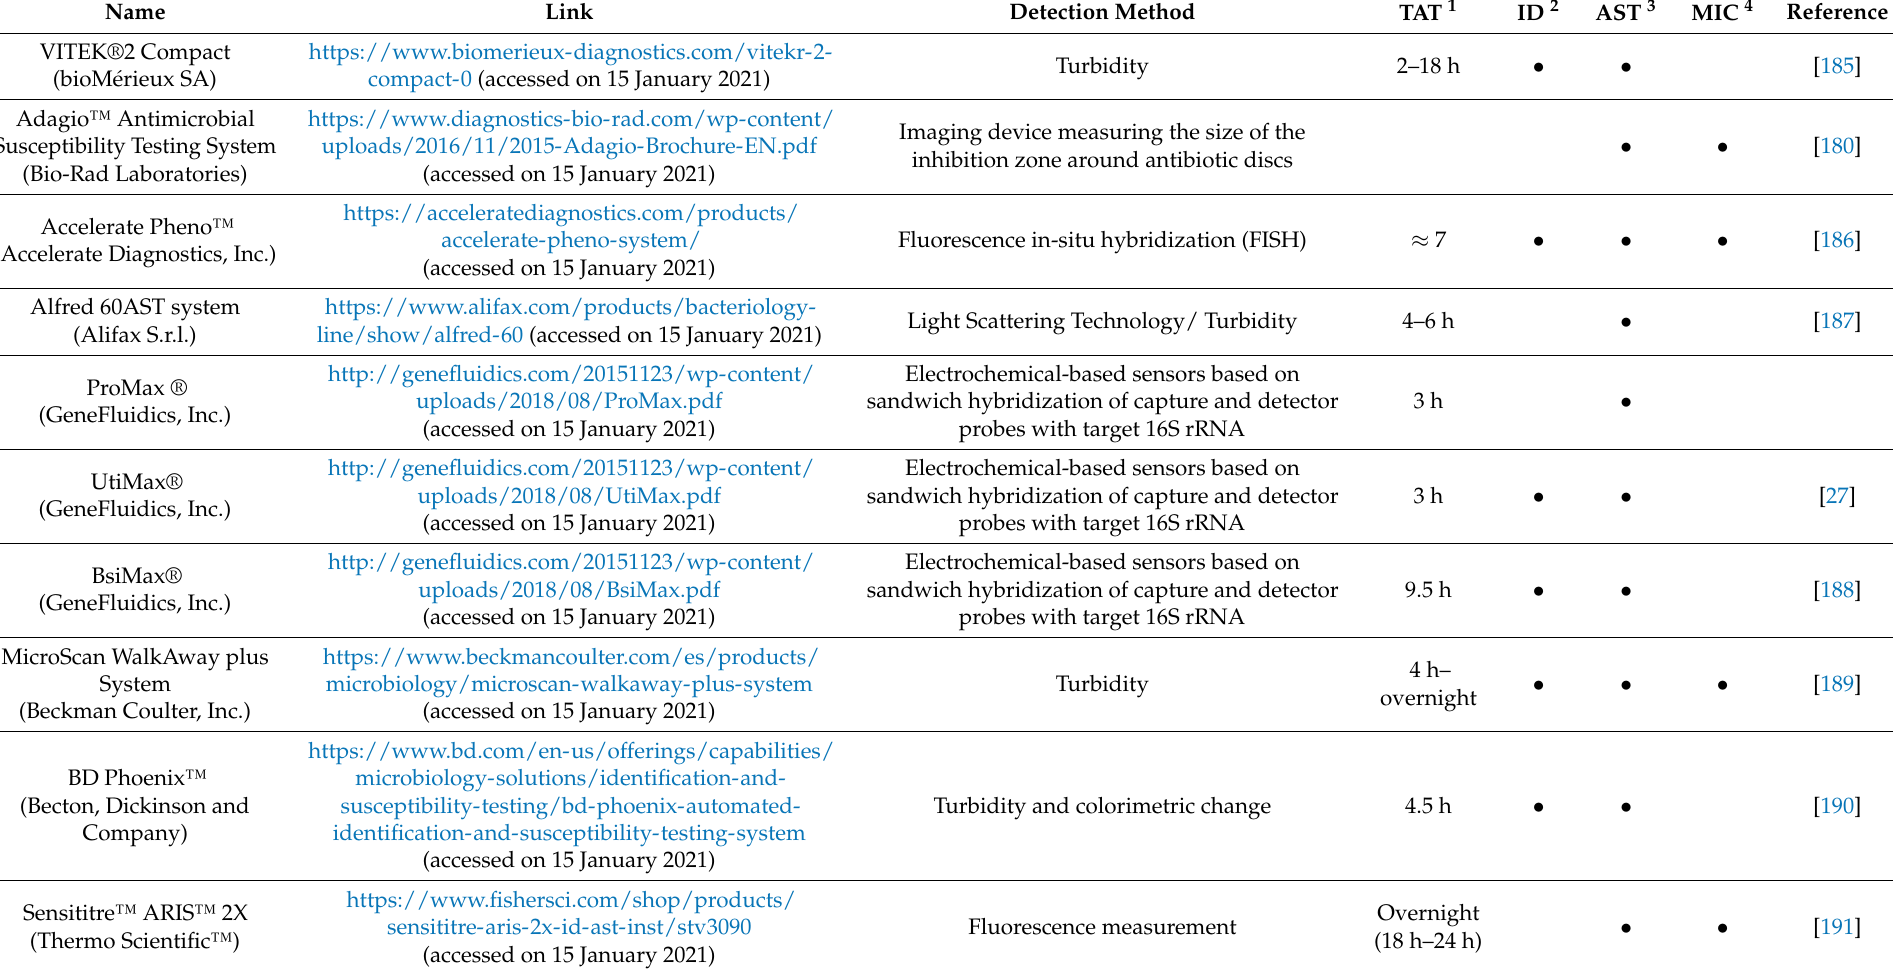
Table 4. Commercially available AST